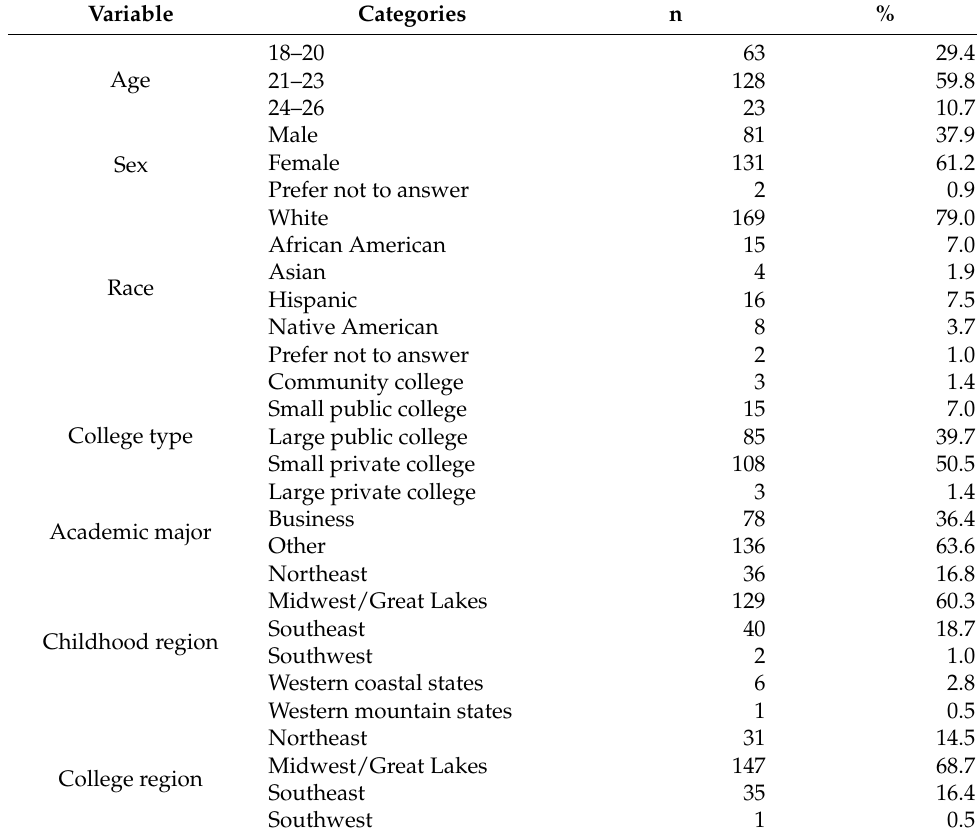
Table 1. Demographic characteristics.